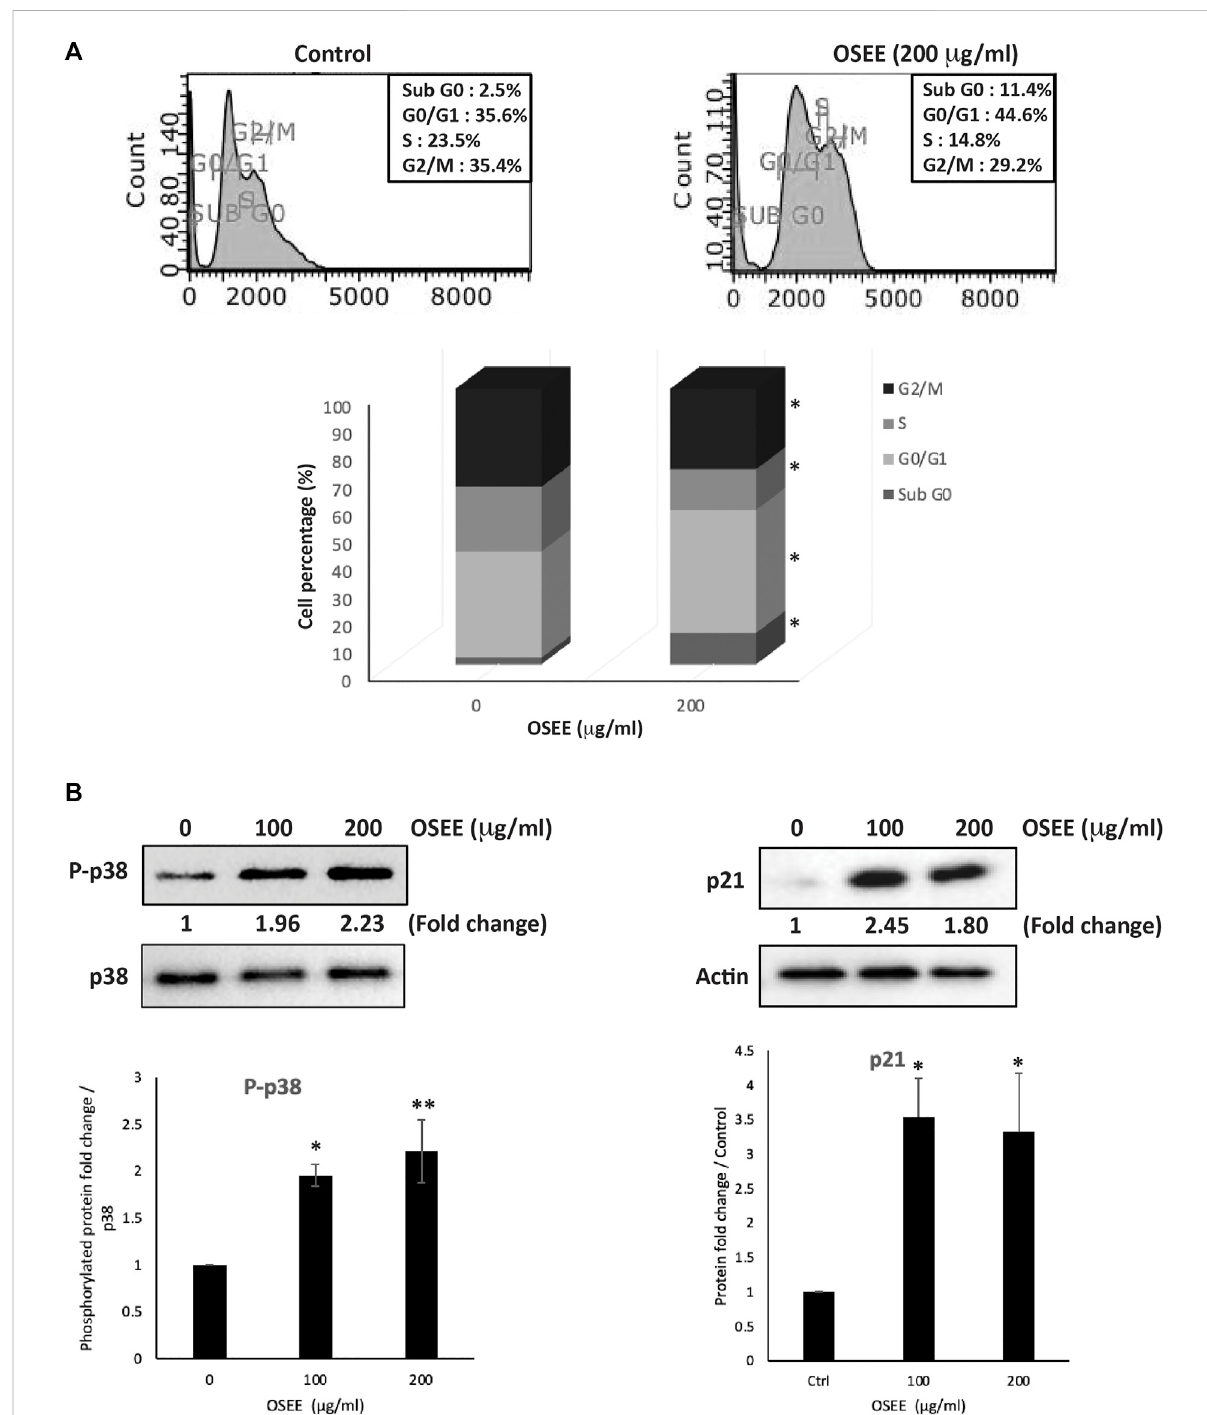
FIGURE 4 O.syriacum inducesG 0 /G 1 cellcyclearrest inMDA-MB-231 cells. (A) MDA-MB-231cellswereincubatedwithOSEE(200 μ g/ml)orethanolasa vehicle control for 24 h. Cells were then harvested, fi xed, stained with propidium iodide, and analyzed by fl ow cytometry as described in Materials and Methods. Data represent the mean ± SEM of three independent experiments. Statistical analysis was performed using one-way ANOVA (* p < 0.05,** p < 0.005) (B) MDA-MB-231cellsweretreatedwithorwithoutincreasingconcentrationsofOSEEfor24 h.Proteinswerethenextracted and the levels of phosphor-p38 and p21 were analyzed by Western blotting, with total-p38 and β -actin as loading controls, respectively. Data represent the mean ± SEM of three independent experiments (* denotes a p < 0.05 and ** denotes a p <